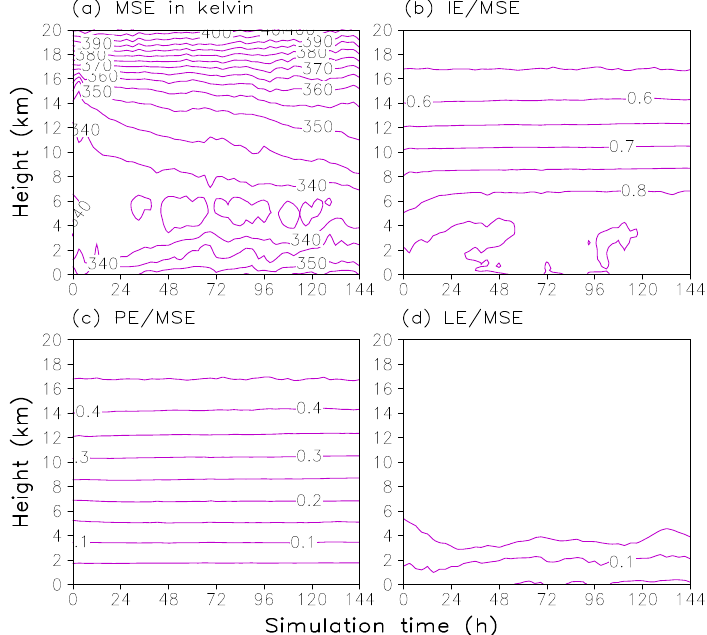
Figure 5. Time series of azimuthal and radial mean ( a ) MSE normalized by c p (K) at contours of 5 K, ( b ) ratio of internal energy (IE) to MSE at contours of 0.05, ( c ) ratio of potential energy (PE) to MSE at contours of 0.05, and ( d ) ratio of latent energy (LE) to MSE in the storm eye at contours of 0.05. Radial average is taken within a radius of 10 km from the storm center.